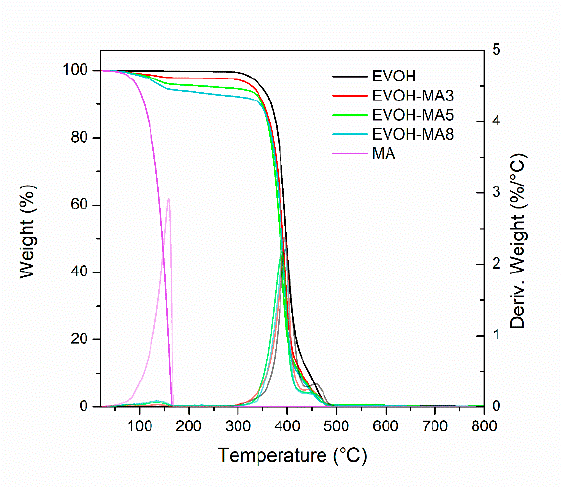
Figure 5. TGA and DTG curves for EVOH-based